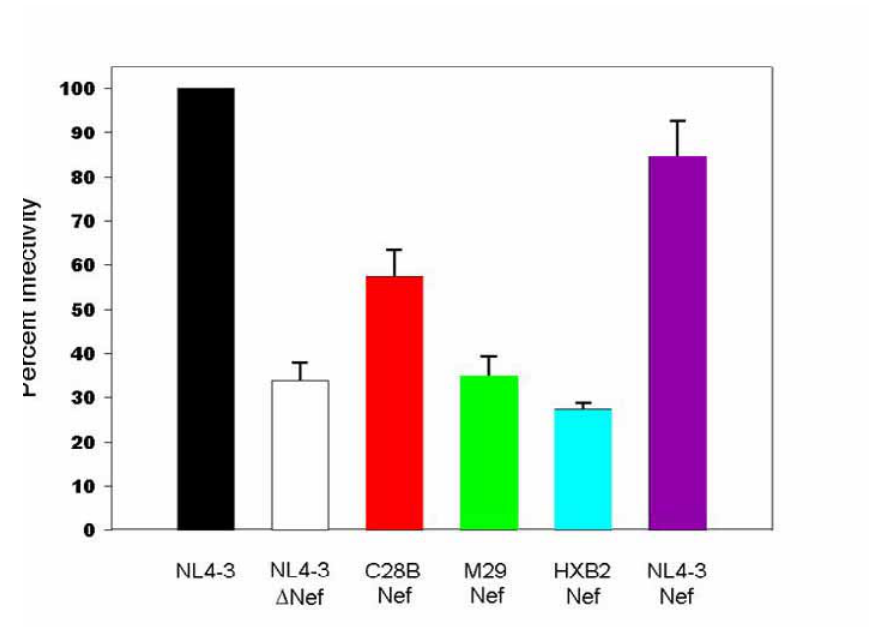
Figure 2. MAGI assay of mother and child Nefs. Average number of blue cells in three separate virions (100%). Error bars indicate standard experiments, compared to values for intact HIV-1 NL4-3 error. From left to right: Intact NL4-3 virus, NL4-3- ∆ Nef (nef-deleted), NL4-3- ∆ Nef complemented with Nef C28B (child), NL4-3- ∆ Nef complemented with Nef M29 (mother), NL4-3- ∆ Nef complemented with Nef